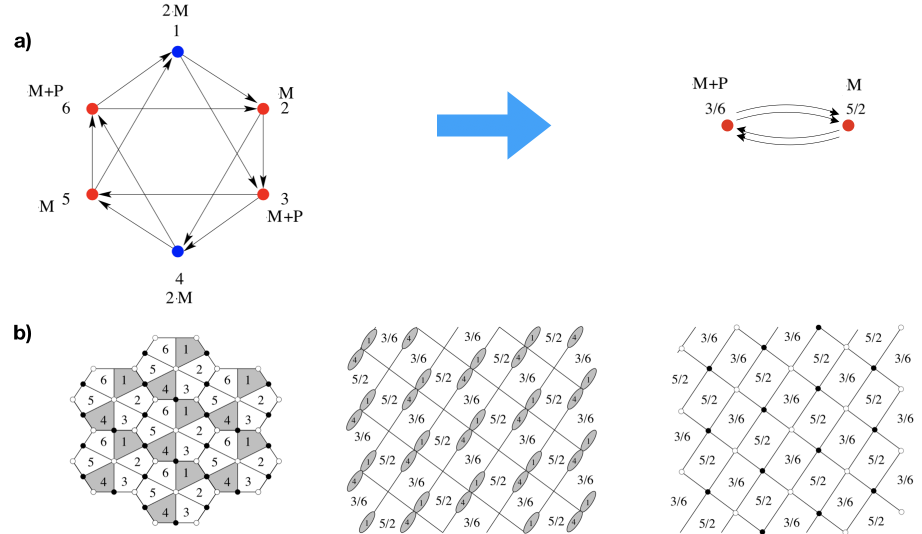
Figure 4 . a) Quiver of the dP 3 theory in the last step of the first cascade, which turns into the conifold upon strong dynamics of the nodes 1 and 4. b) Same story in the dimer